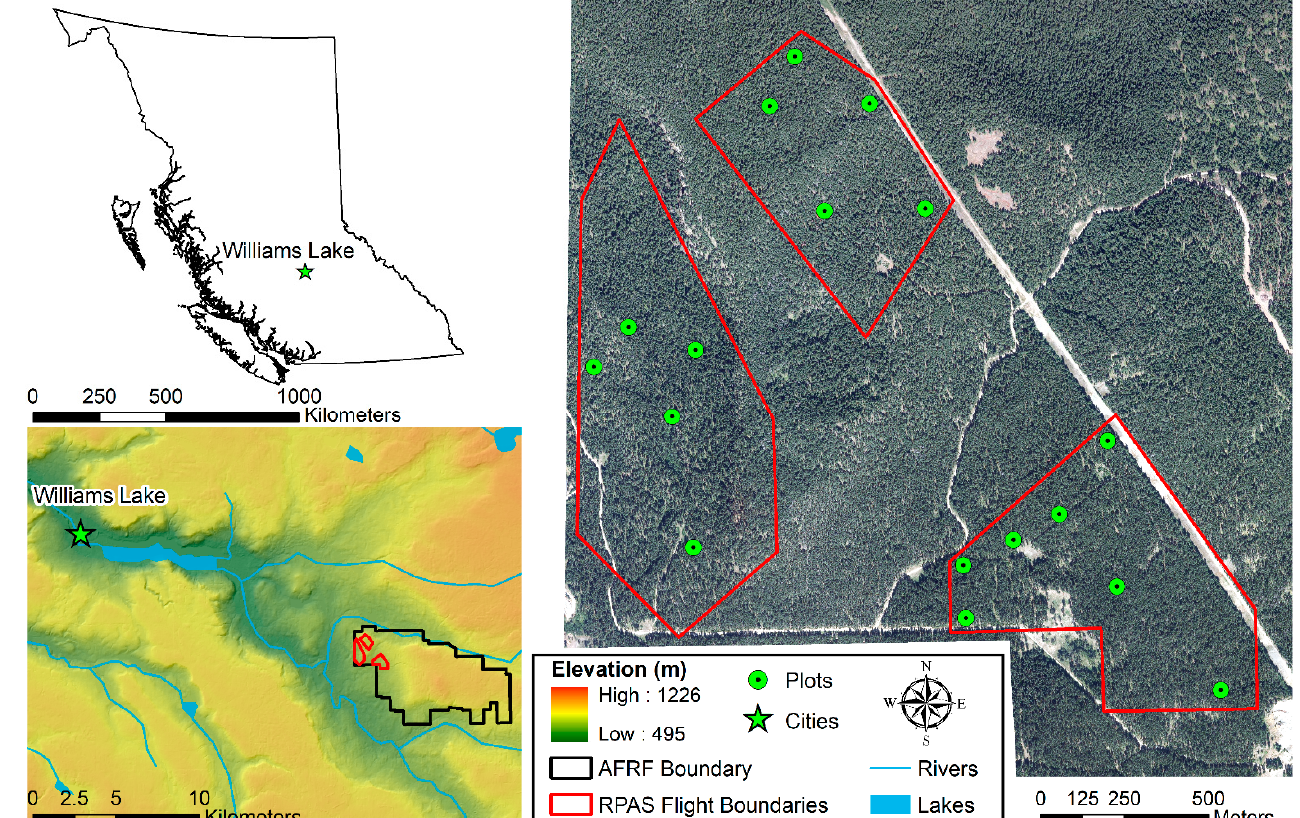
Figure 1. Location of the 17 plots in the Alex Fraser Research Forest (AFRF) near Williams Lake, Canada.